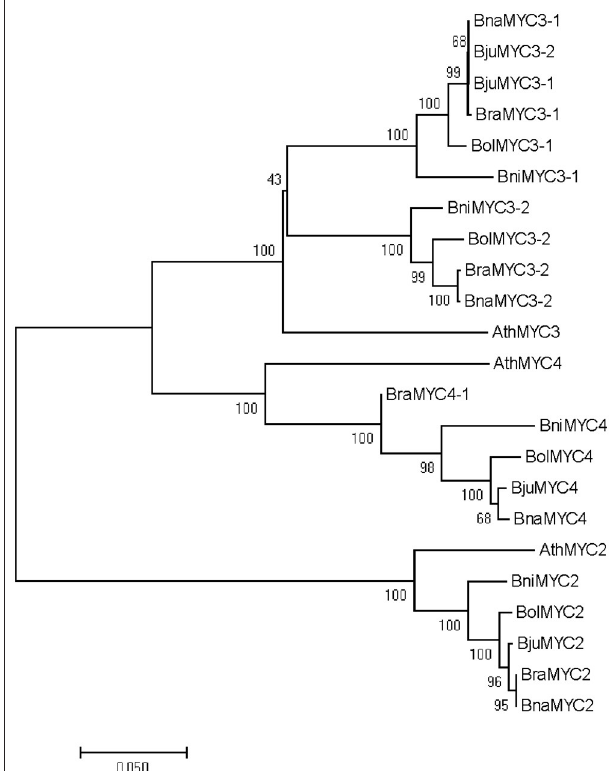
FIGURE 2 | Phylogenetic tree of BrMYC2/3/4. Evolutionary analyses of full-length MYC2/3/4 coding sequences involved in the U’s triangle of Brassica species. Numbers on the branches indicate the percentage of bootstrap support from 1,000 replicates; branch length represents the divergence distance. Ath, Arabidopsis thalinala ; Bra, Brassica rapa ; Bni, Brassica nigra ; Bol, Brassica oleracea ; Bna, Brassica napus ; Bju, Brassica juncea .